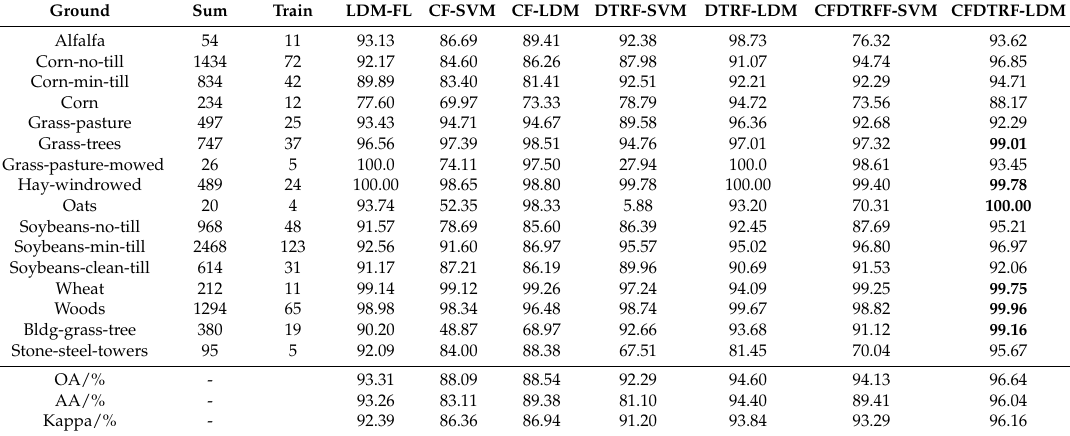
Table 2. Comparison of classification accuracies (in percent) provided by seven methods for Indian Pines (part B).